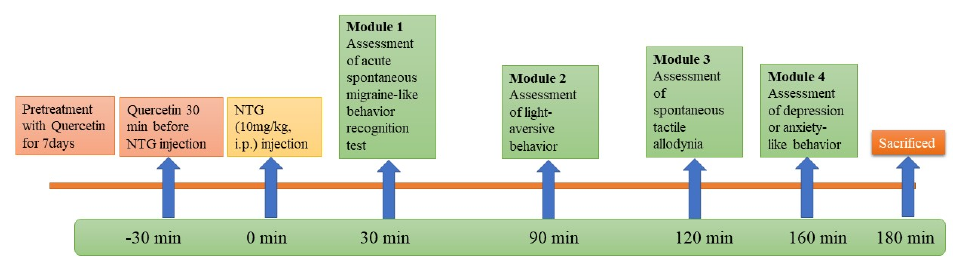
Figure 1. Workflow for animal study.